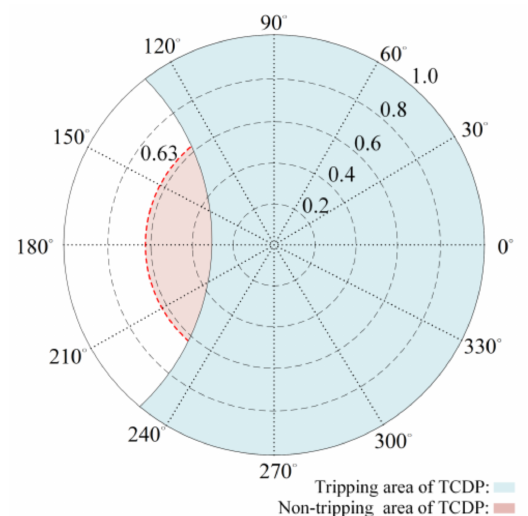
Figure 5. Action characteristics of the TCDP in active distribute